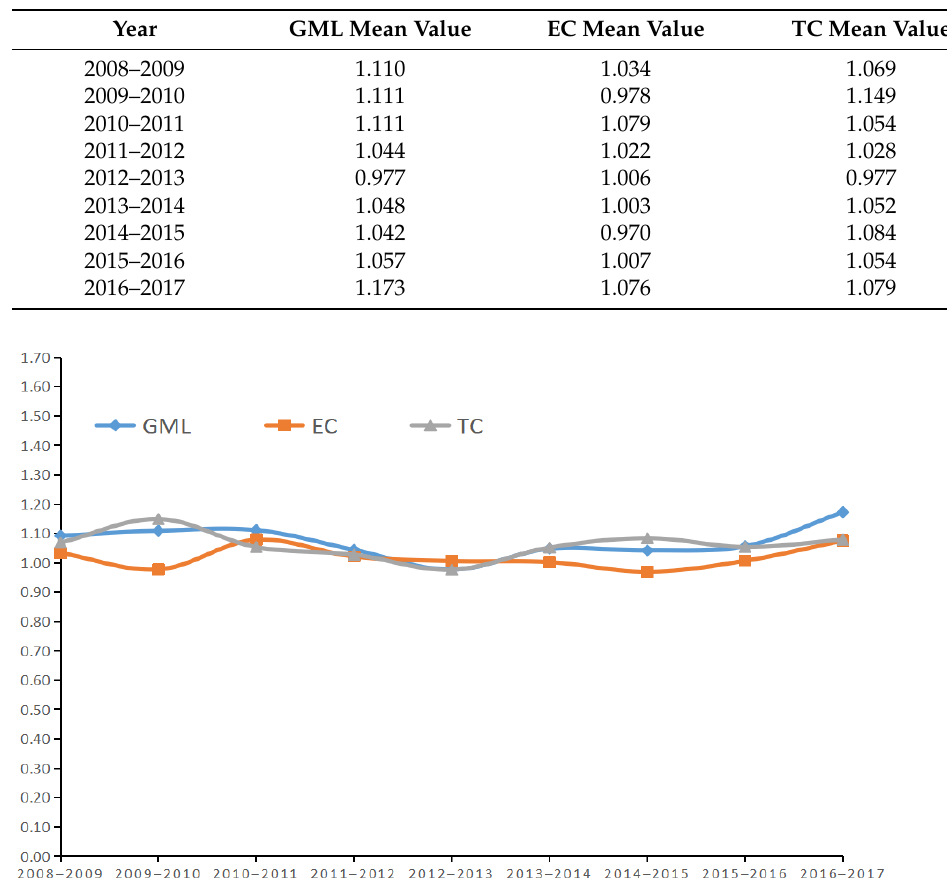
Figure 3. Average GML index and its decomposition line chart of each Year in China.